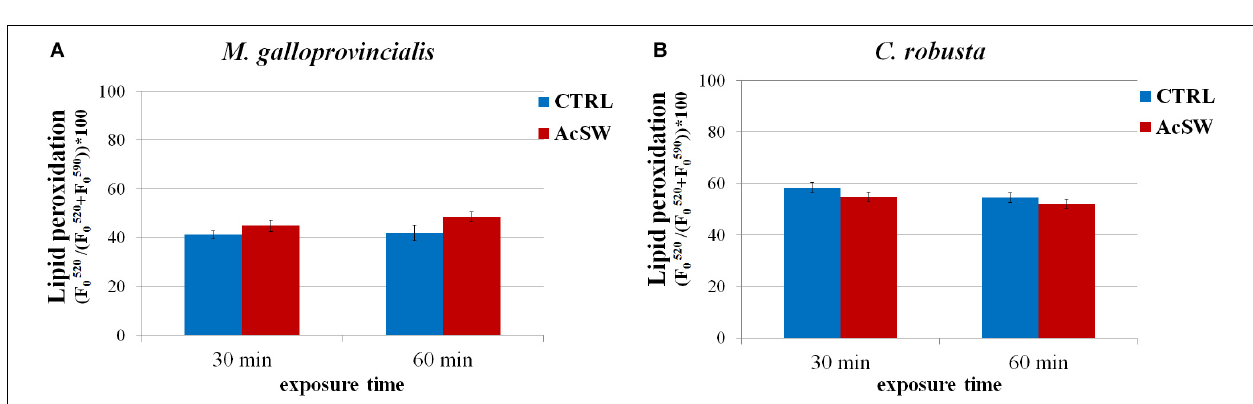
FIGURE 4 | Effects of acidified seawater (AcSW) on plasma membrane lipid peroxidation in spermatozoa of M. galloprovincialis (A) and C. robusta (B) (mean ± SE). Lipid peroxidation was determined as a ratio between fluorescence emission peak value at ∼ 520 nm and the sum of fluorescence emission peak values at ∼ 520 and ∼ 590 nm after exposure for 30 and 60 min to filtered natural seawater with a natural pH of 8.1 (CTRL) and to AcSW with a pH of